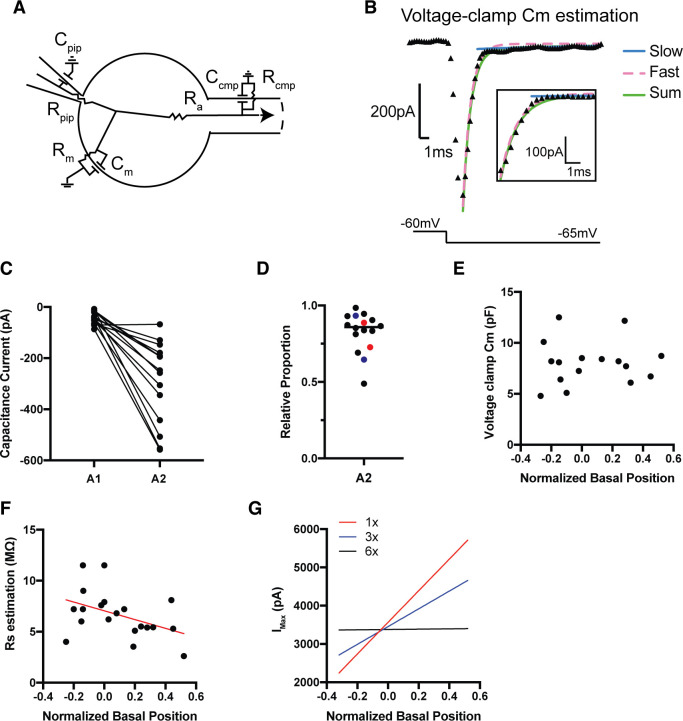
Considering the influence of space-clamp and series resistance errors.(A) Circuit diagram of an acute SGN in the semi-intact preparation clamped in whole-cell configuration. This diagram shows the series resistance (Rpip), membrane resistance (Rm), axial resistance (Ra), and a secondary compartment resistance from the neurite (Rcomp) with corresponding capacitors (C). (B) Voltage-clamp response of the transient capacitance current of an SGN in the semi-intact preparation fitted with a bi-exponential function (green trace). The fast (pink trace) and slow (blue trace) components of the bi-exponential function are plotted to show the contribution of the current coming for the somata (fast/pink) and neurite (slow/blue). (C) The relative size of the magnitude of the fast (A2) and slow (A1) components of the trace, indicating that the fast component dominates the fit and currents are measured primarily from the soma. (D) The fast component of the bi-exponential (A2) relative proportion to the sum of the bi-exponential function (A1+A2). A2 relative proportion dominates in both modiolar(red) and pillar (blue) contacting SGN. (E) Cell capacitance, measured as the integral of the capacitance current, is not correlated with basal position (r = 0.05, p=0.85). (F) Series resistance as a function of normalized basal with the mean trend line is shown in red. (G) After performing series resistance error corrections per cell, we see that the position correlation of maximum outward current (Imax) and NBP does not collapse, and remains correlated (R2 = 0.23, p=0.0003). If we simulate increasing levels of systematic series resistance errors by three (blue trace) and six (black trace) times the amount we measured, trends along NBP do not collapse.